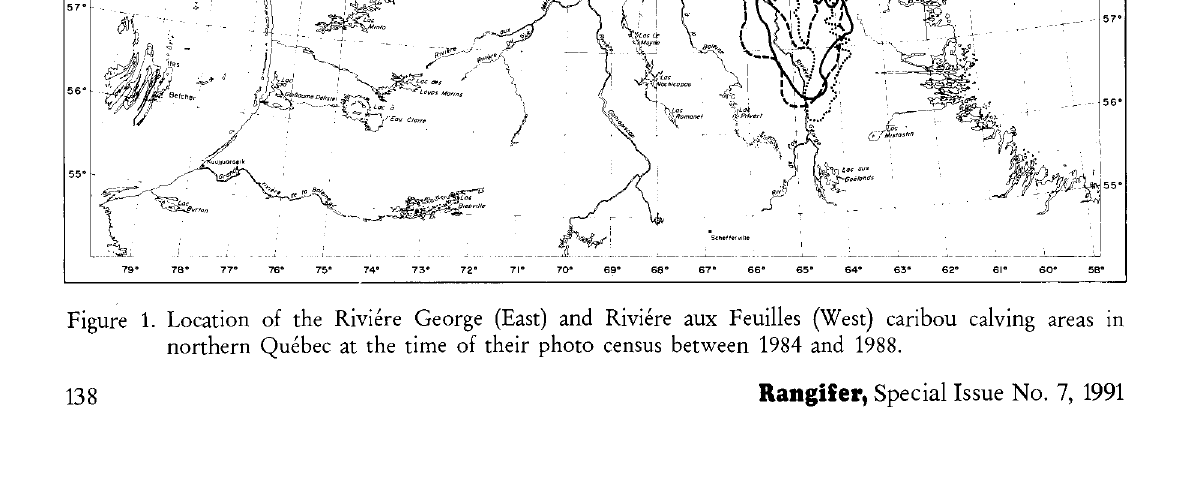
Figure 1. Location of the Rivière George (East) and Rivière aux Feuilles (West) caribou calving areas in northern Québec at the time of their photo census between 1984 and